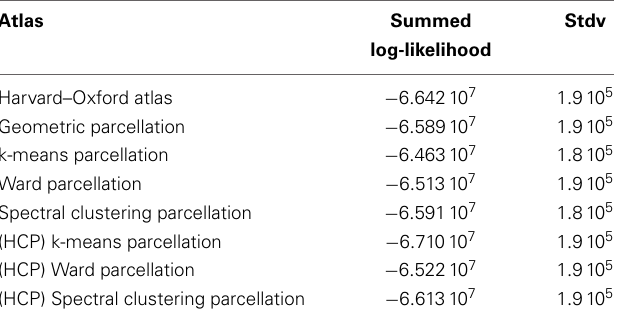
The number of parcels used is K = 158 for all methods. The standard deviation is obtained by drawing 30 bootstrap